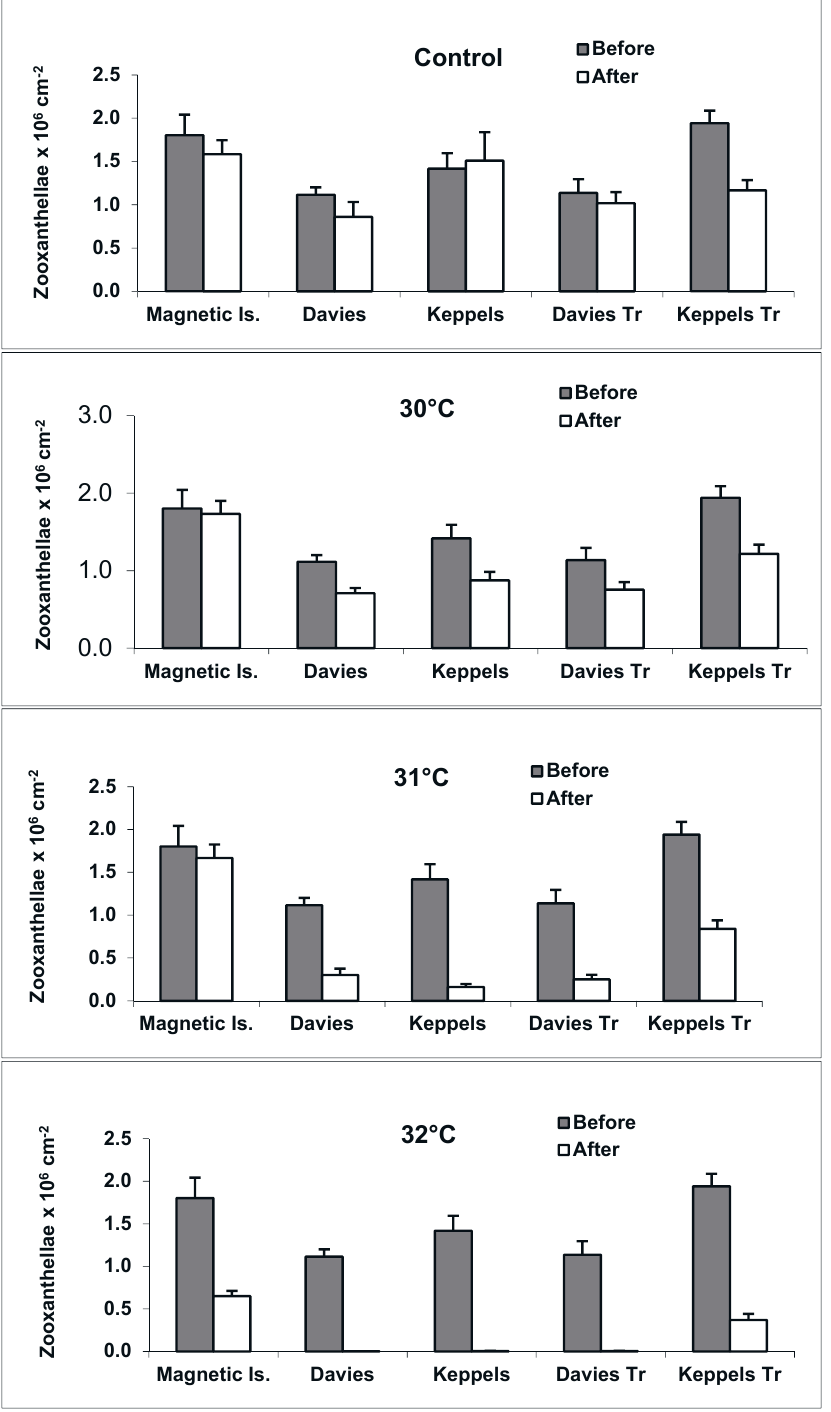
Figure 3. Zooxanthellae density ± SE (bars) of coral nubbins ( n = 18 per temperature treatment) before and after 15-d of heat stress at control (27.5 °C), 30, 31, and 32 °C in each of five experimental populations from the five sites: Maggie (Magnetic Island); North Keppel Island native; Keppel Transplants; Davies Reef native; and Davies Transplants. (Source: Ray Berkelmans). (See Figure 3 in [22] for details of healthy, pale, white, dead